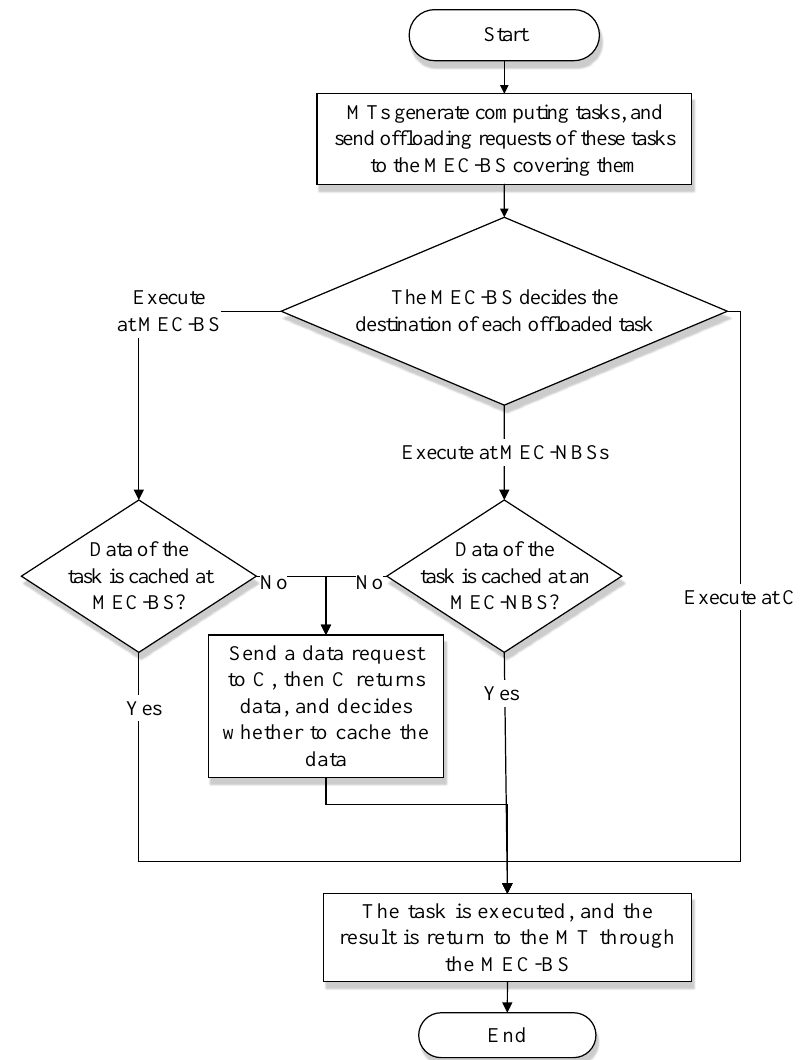
Figure 3. Flowchart of the Cooperative Resource Management